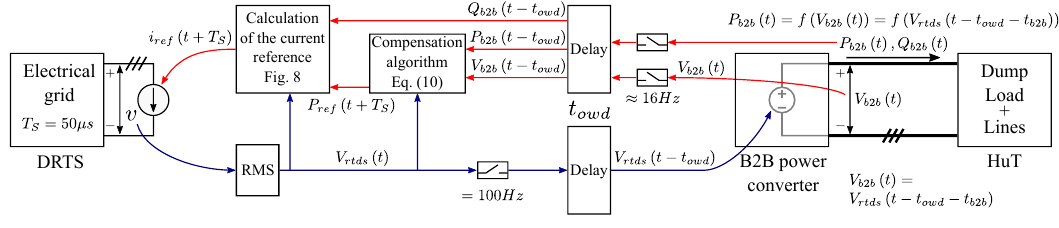
Figure 7. Overview of the interface algorithm.